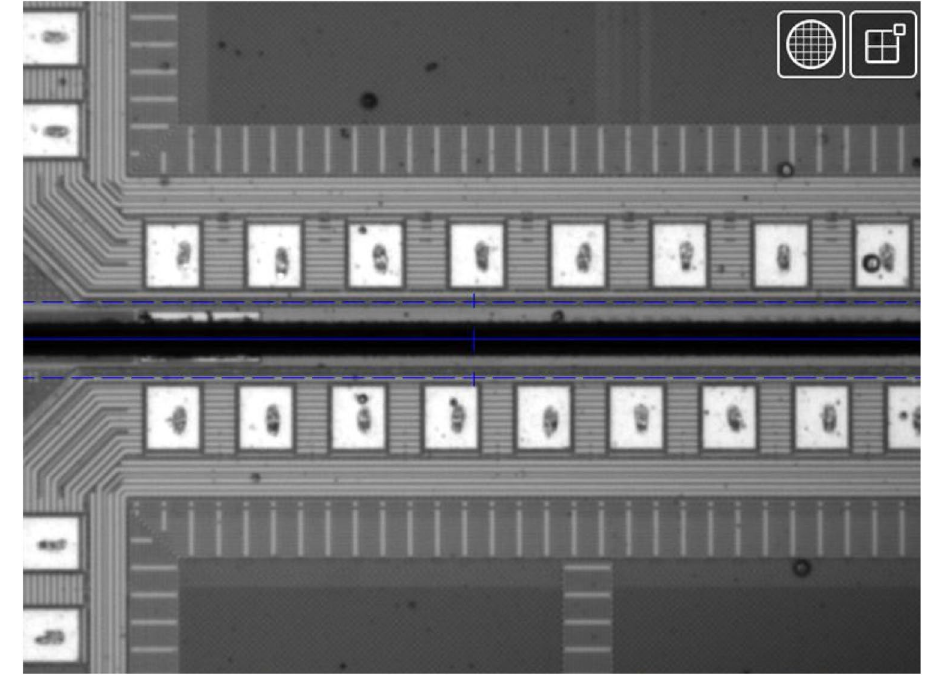
Fig. 11 The effect of knife marks under high magnifica- tion